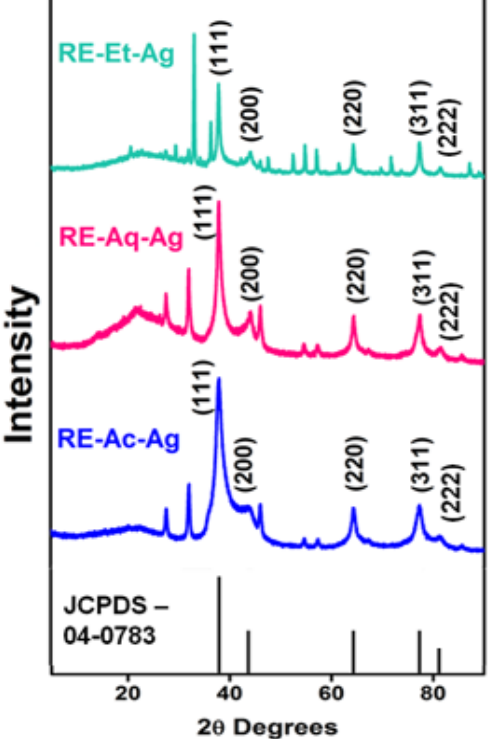
Figure 1. XRD patterns of RE-Ac-Ag, RE-Aq-Ag, and RE-Et-Ag